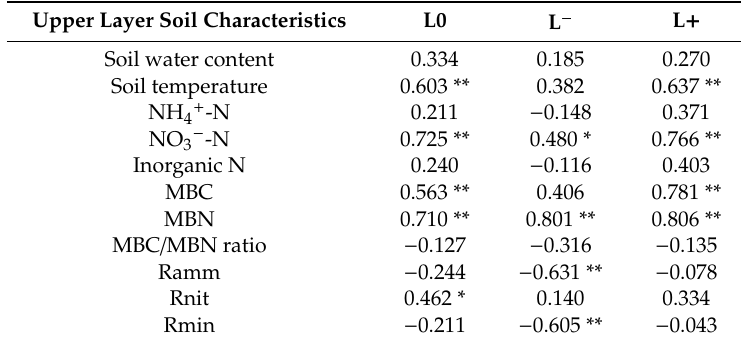
Table 5. Pearson correlation coefficients between upper layer soil characteristics and the monthly flux of N 2 O for L0, L − , and L+ in the Larix gmelinii forest Upper Layer Soil Characteristics